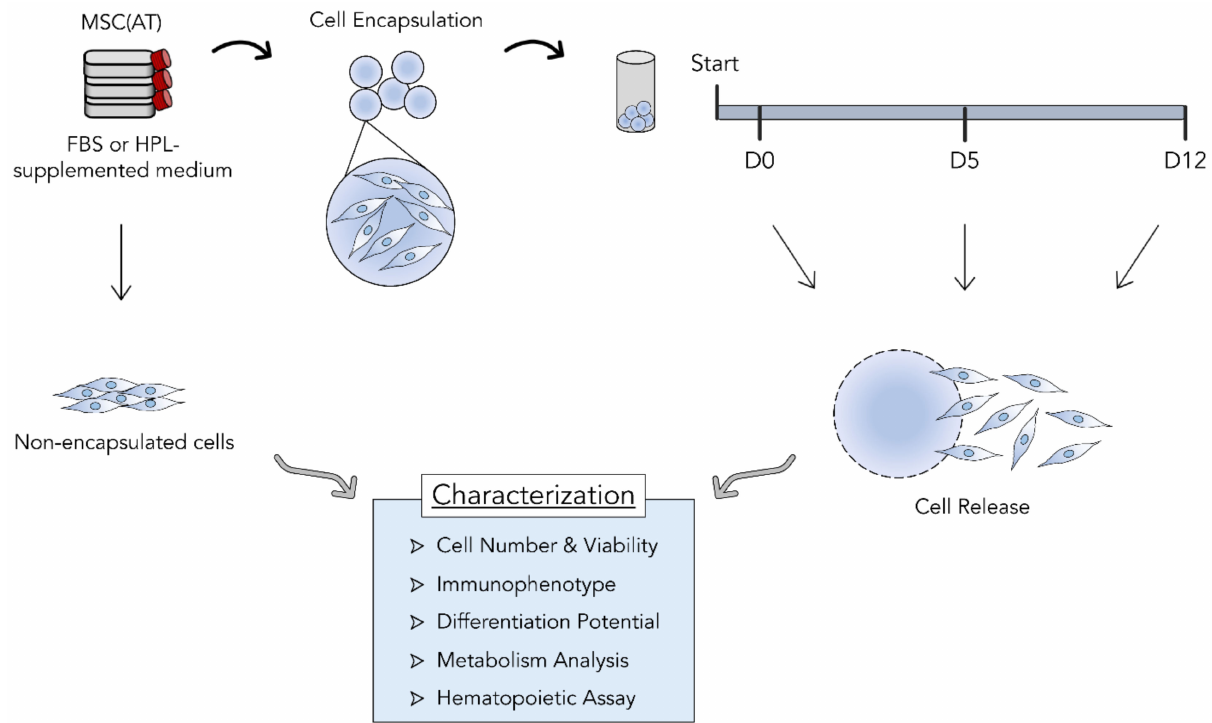
Figure 1. Study design. Three different adipose tissue-derived mesenchymal stromal cell (MSC(AT)) donors were expanded in fetal bovine serum (FBS) or human platelet lysate (HPL)-supplemented expansion medium in standard tissue culture plastic. MSC(AT) were encapsulated in alginate beads and kept at temperatures between 10 and 20 ◦ C after reaching desired temperatures. MSC(AT) were left encapsulated during three different time periods: 30 min (D0), 5 days (D5), and 12 days (D12). Cells were then released and subjected to different characterization assays and compared with non-encapsulated MSC(AT). Cell retainment and survival during encapsulation, MSC identity and functional immunophenotype, MSC tri-lineage differentiation potential, metabolic activity, and hematopoietic support capacity were determined and compared between